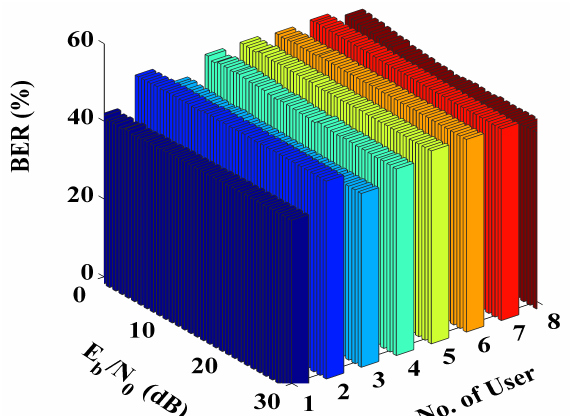
Figure 16. BER performance for the different mMTC users without improved 3D controlled Lorenz mapping system-aided PLS decryption scheme.